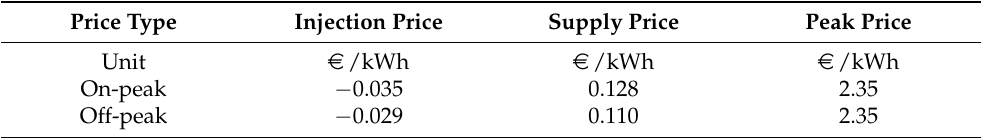
Table 2. Electricity prices used in the internal calculations to perform energy balance with an energy cost minimization algorithm (source: all prices originate from an industrial site in